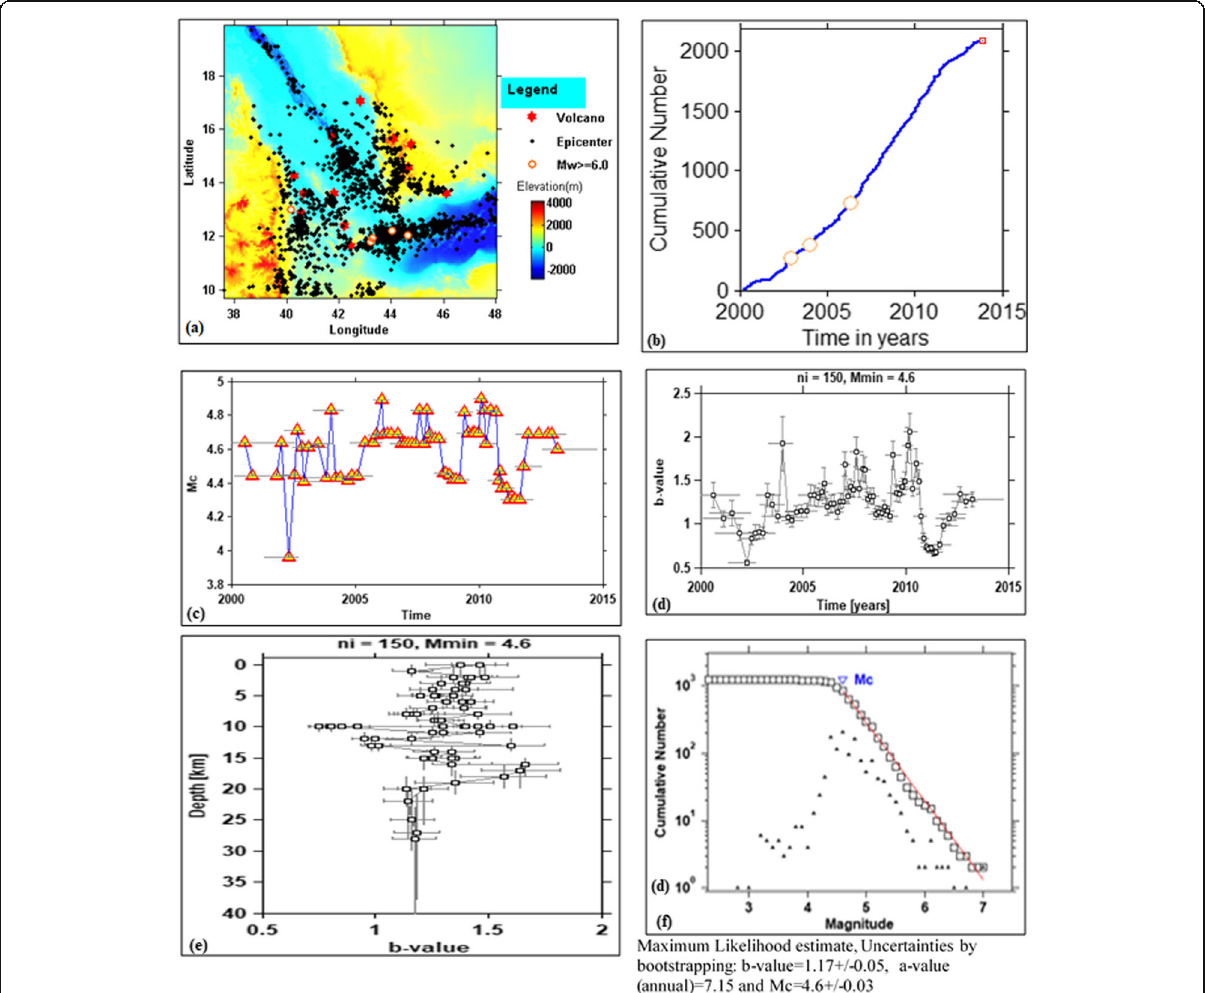
Fig. 6 Afar Rifts (Including Red Sea and Gulf of Aden): ( a ) Seismicity map of the region ( b ) Cumulative number of events vs time-straight-line trend -relatively complete ( c ) Magnitude of Completeness (Mc) with time ( d ) Temporal variation of b-value with period of completeness, ni = 150, Mmin = 4.6 ( e ) Spatial variation of b-value with depth, ni = 150, Mmin = 4 ( f ) average b and a-values of the region by maximum likelihood